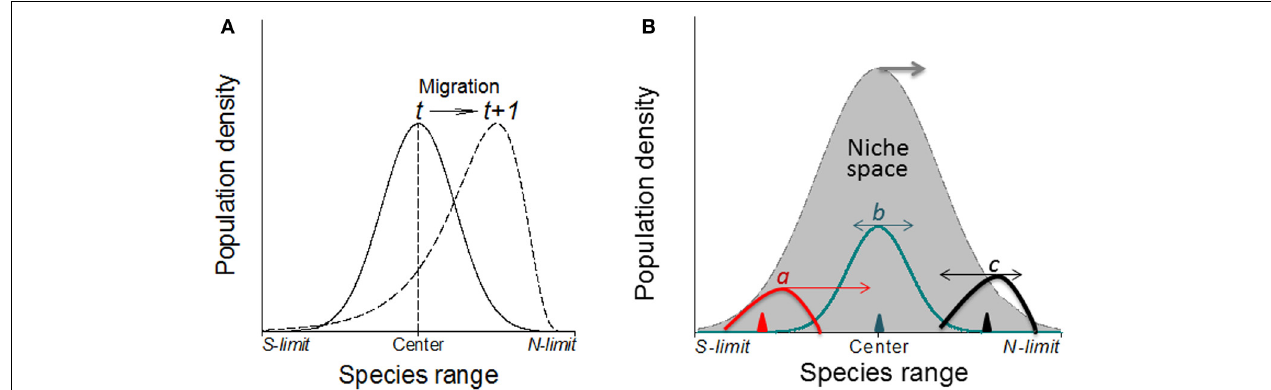
FIGURE 7 | (A) Without physical barriers, the deviation of the abundance curve of a species from Gaussian distribution may indicate the migration direction under warming climates (in northern hemisphere; e.g., Maggini et al., 2011). Here, the population or the whole species range is moving toward the left where the abundance curve shows a much steeper slope than